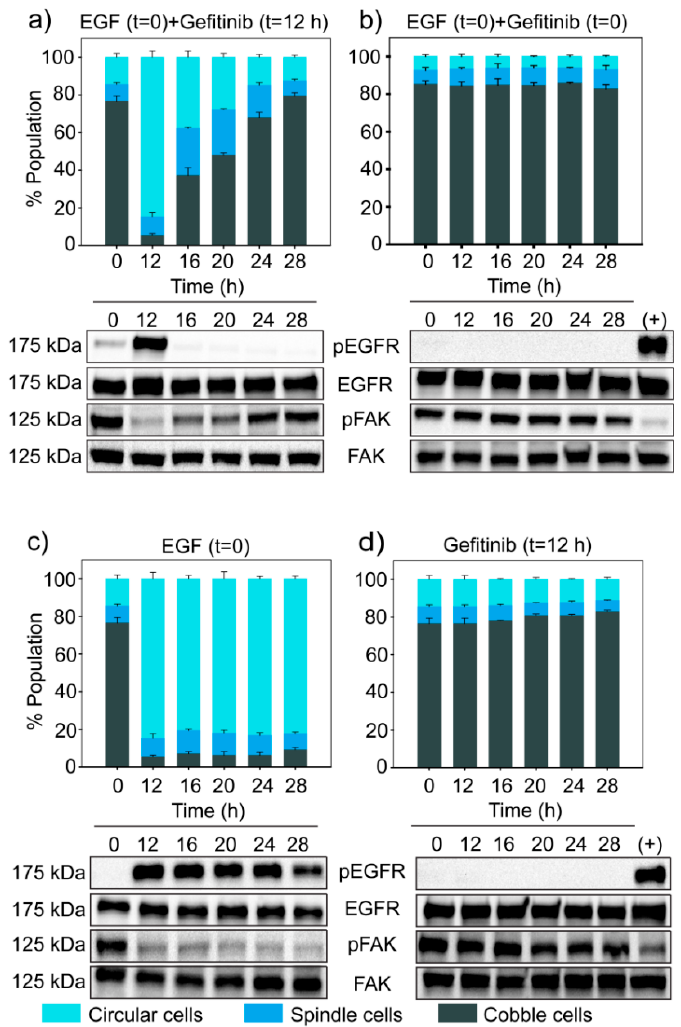
Figure 7. Blocking EGFR turns the ultrasensitive switch OFF. MDA-MB-468 cells were treated with different experimental conditions—( a ) EGF (25 ng/mL) at t = 0 and Gefitinib (0.2 µM) at t = 12 h, ( b ) EGF (25 ng/mL) and Gefitinib (0.2 µM) together at t = 0, ( c ) only EGF (25 ng/mL) at t = 0, and ( d ) only Gefitinib (0.2 µM) at t = 12 h. For all the experimental conditions, EGFR, phospho-EGFR, FAK and phospho-FAK were measured by Western blotting and the corresponding population distribution was estimated through quantitative image analysis. EGF treated samples were used as positive control for phospho-EGFR in (b) and (d). The bar graph represents quantitative data from image analysis. Each data point represents the mean of three independent experiments and error bars indicate standard deviation.